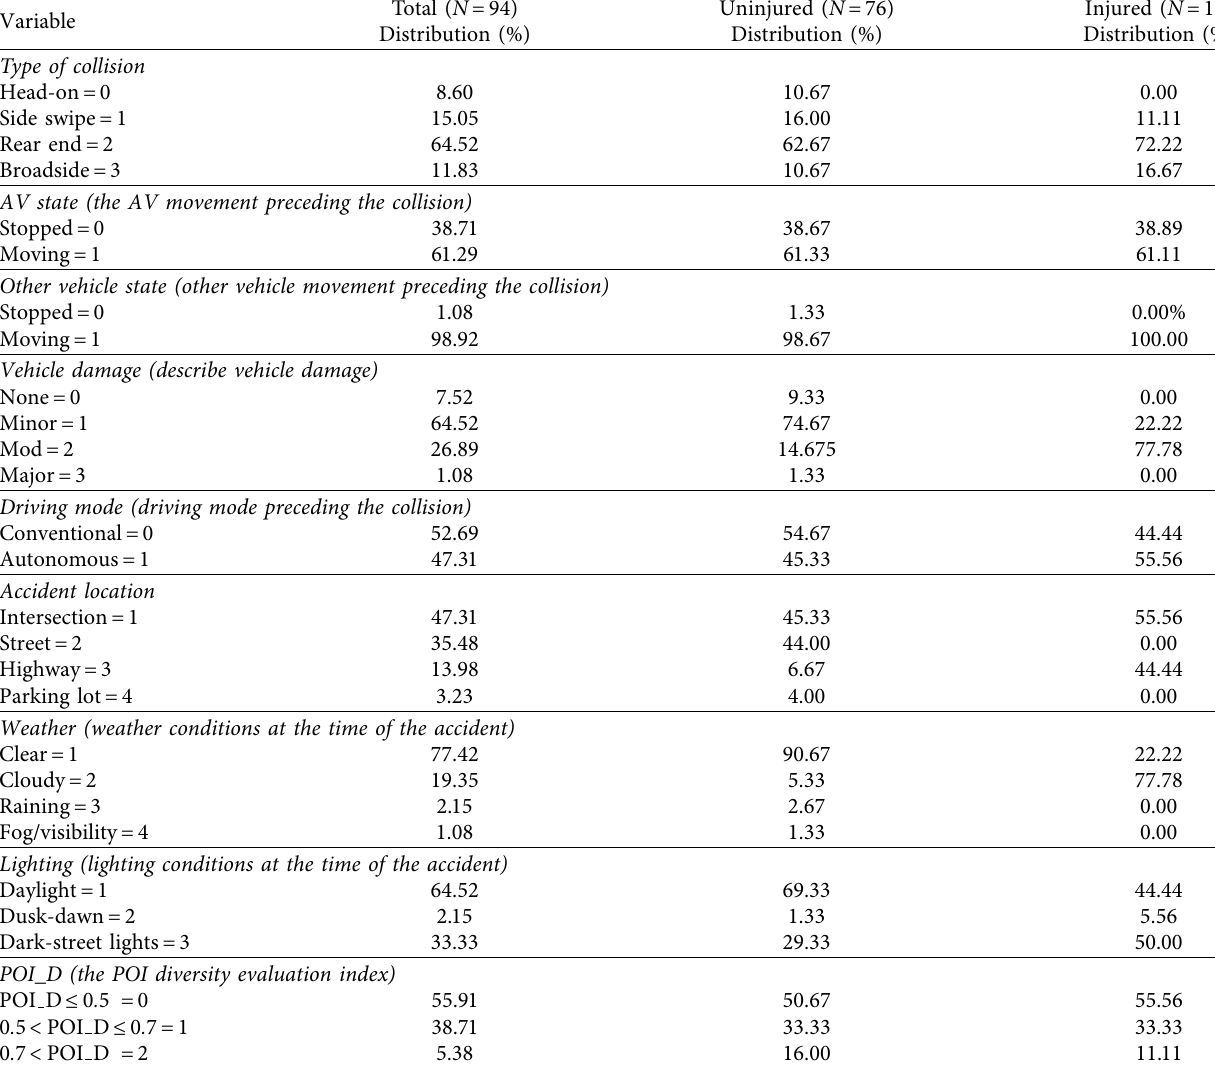
Table 2: Variables description and distribution.